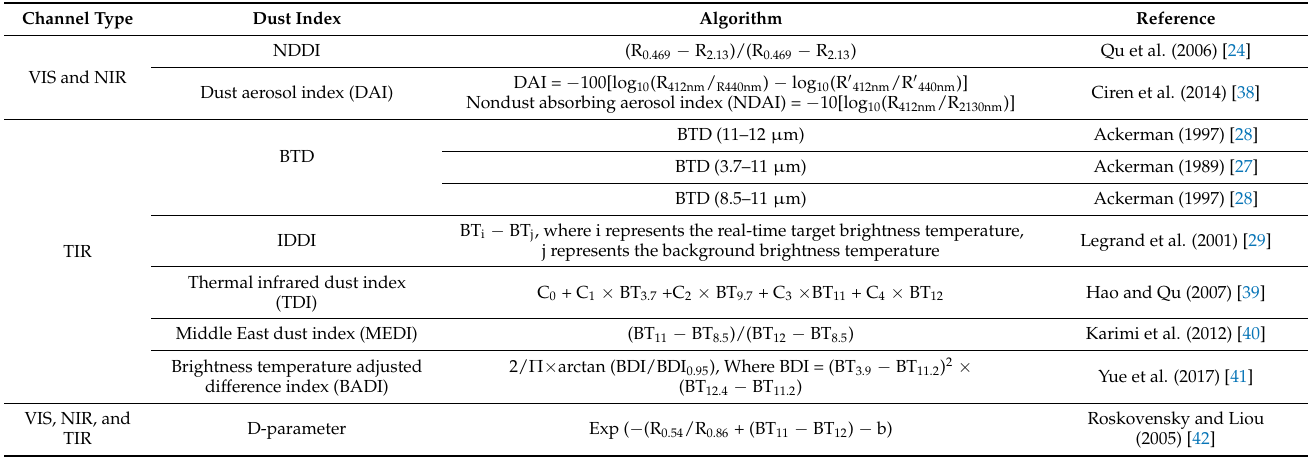
Table 1. Summary of the dust detection